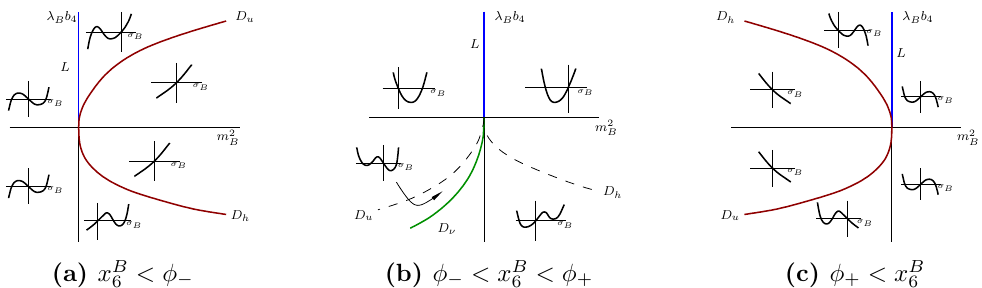
Figure 26. The phase diagram of the RB theory for various choices of the parameter x B LG potential (A.16) is plotted as a small inlay in each region of parameter space. In each inlay, the range (cid:27) B < 0 corresponds to the unHiggsed branch of the potential while the range (cid:27) B > 0 corresponds to the Higgsed branch. The curves demarcating di(cid:11)erent regions of parameter space are explained in the